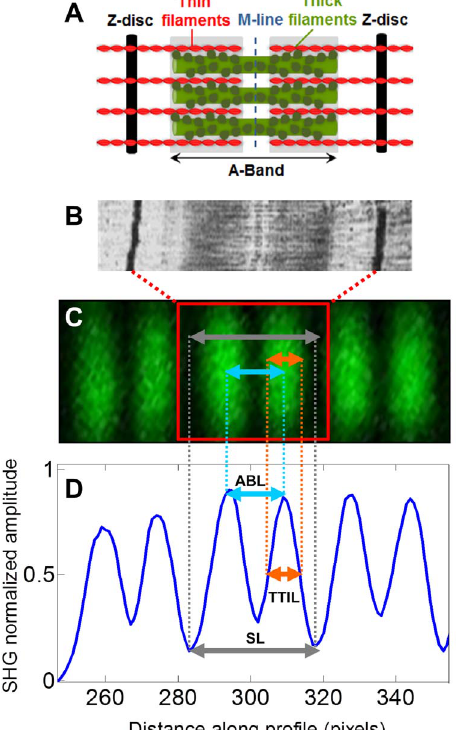
Figure 1. Schematic representation of the sarcomere cytoskel- eton distances. A , an illustration of the sarcomere elementary parts; B , a sarcomere image by electron microscopy; C , a SHGM image of a myofibril; and D , a SHGM intensity profile along the myofibril showing the distances measured to characterize the sarcomere cytoskeleton: sarcomere length (SL), intra-sarcomeric A-band lengths (ABL) and thick- thin filament interaction length (TTIL).